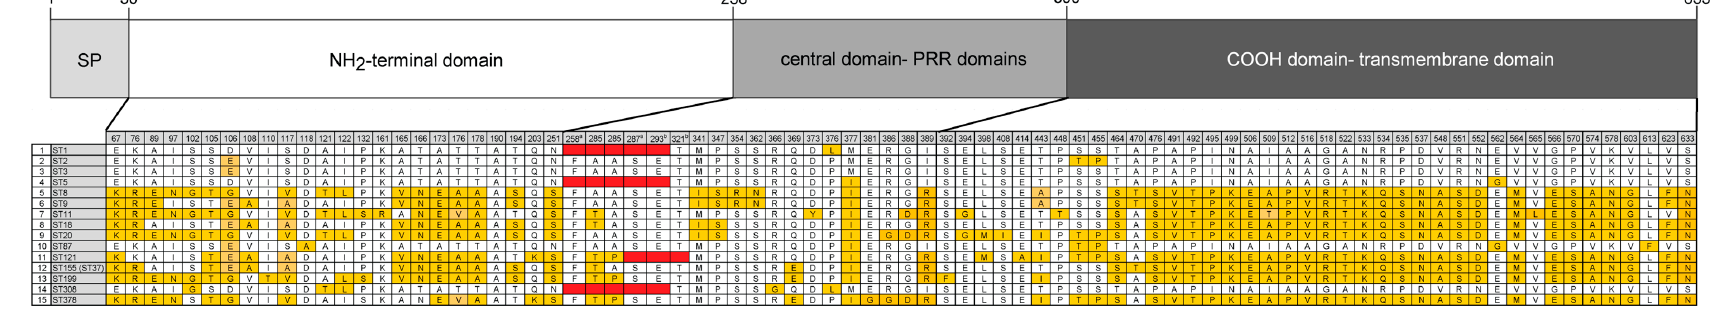
Figure 6. ActA variants. Analysis of ActA amino acid sequence of 57 L. monocytogenes isolates revealed 15 different variants. ActA functional domains are represented as distinct blocks. SP: signal peptide, PRR: proline reach repeat; Different variants are presented by isolates of the same ST with two exceptions. ST37 and ST155 isolates harbor the same ActA variant. Red indicates internal truncation. a start and b end of the internal truncation.